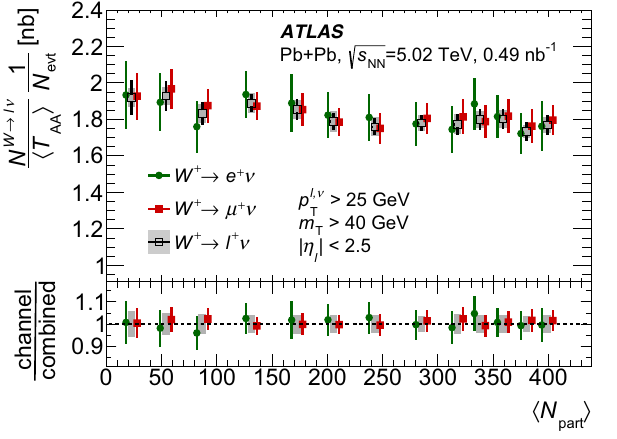
Fig. 9 Normalised production yields for W + (left) and W − (right) bosons as a function of (cid:4) N part (cid:5) shown separately for electron and muon decay channels as well as for their combination. Statistical and sys- tematic uncertainties of the combined yields are shown as bars and shaded boxes, respectively. For the individual channels, only the total uncertainties are shown as error bars. Systematic uncertainties related